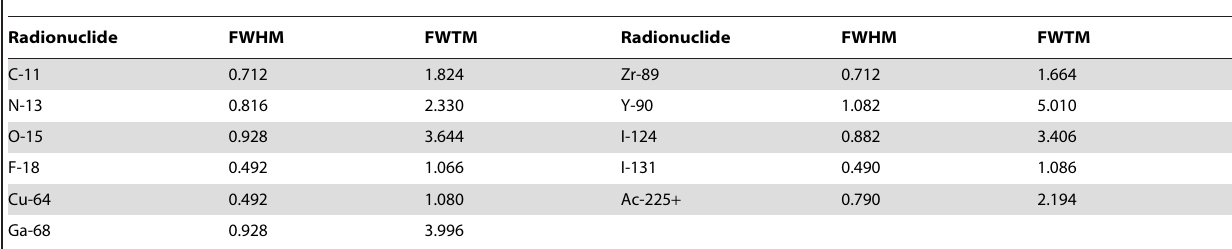
Table 5. CR from b PSF width